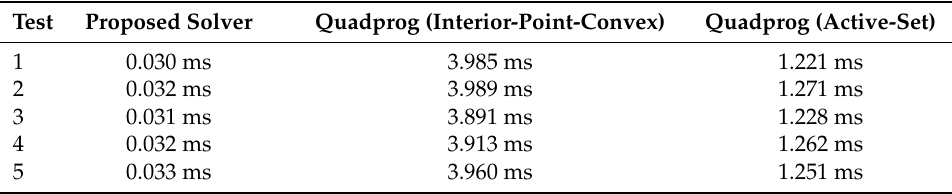
Table 2. Comparison of the computational times.